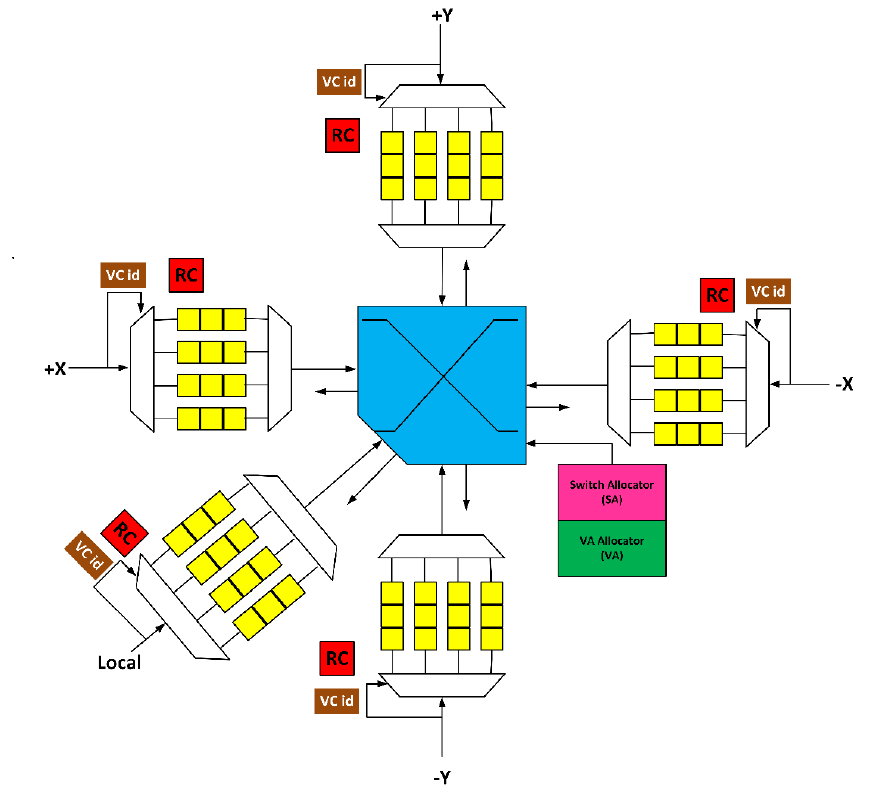
Figure 1. Baseline network-on-chip (NoC) router micro